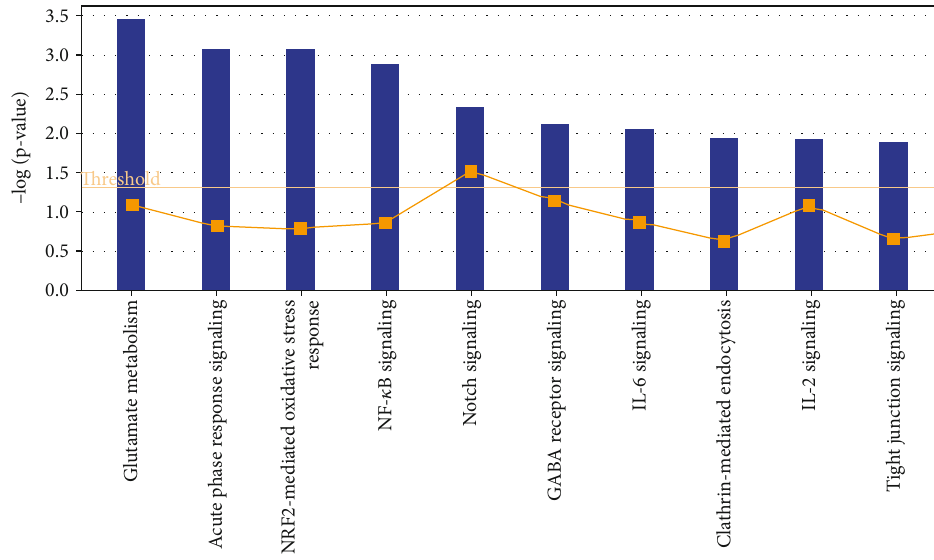
Figure 2: Top 10 typical cell pathways a ff ected by DTS